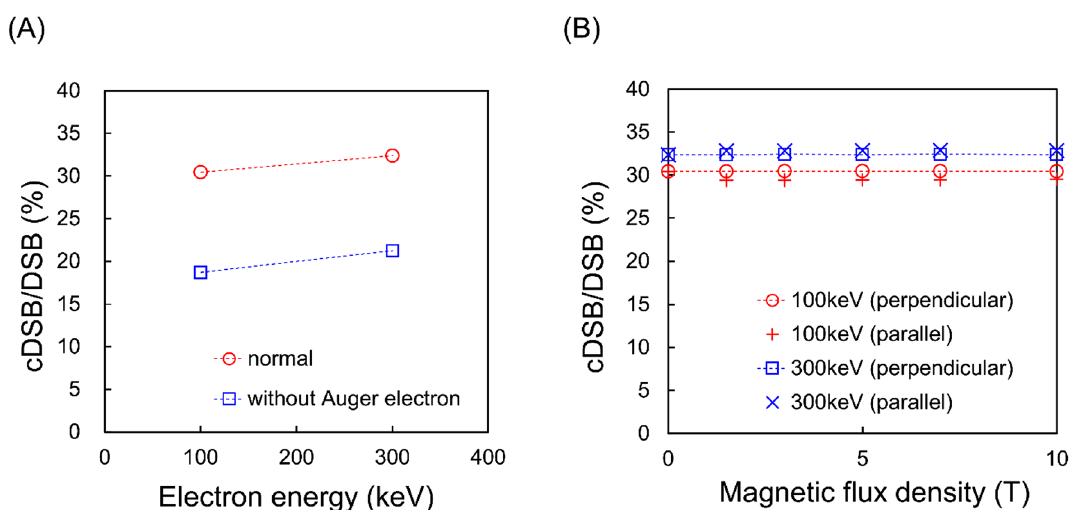
Figure 5. Various calculation results related complex DNA damage induction. ( A ) shows the relationship between the ratio of complex DSB yields per all DSBs yields (cDSB/DSB) and electron energy (100 and 300 keV). ( B ) shows the cDSB/DSB for 100, 300 keV electrons for various intensities of SMF, which is the ratio of the complex DSB yields calculated using PHITS (v. 3.27) and the analytical code for estimating DNA damage yields 24